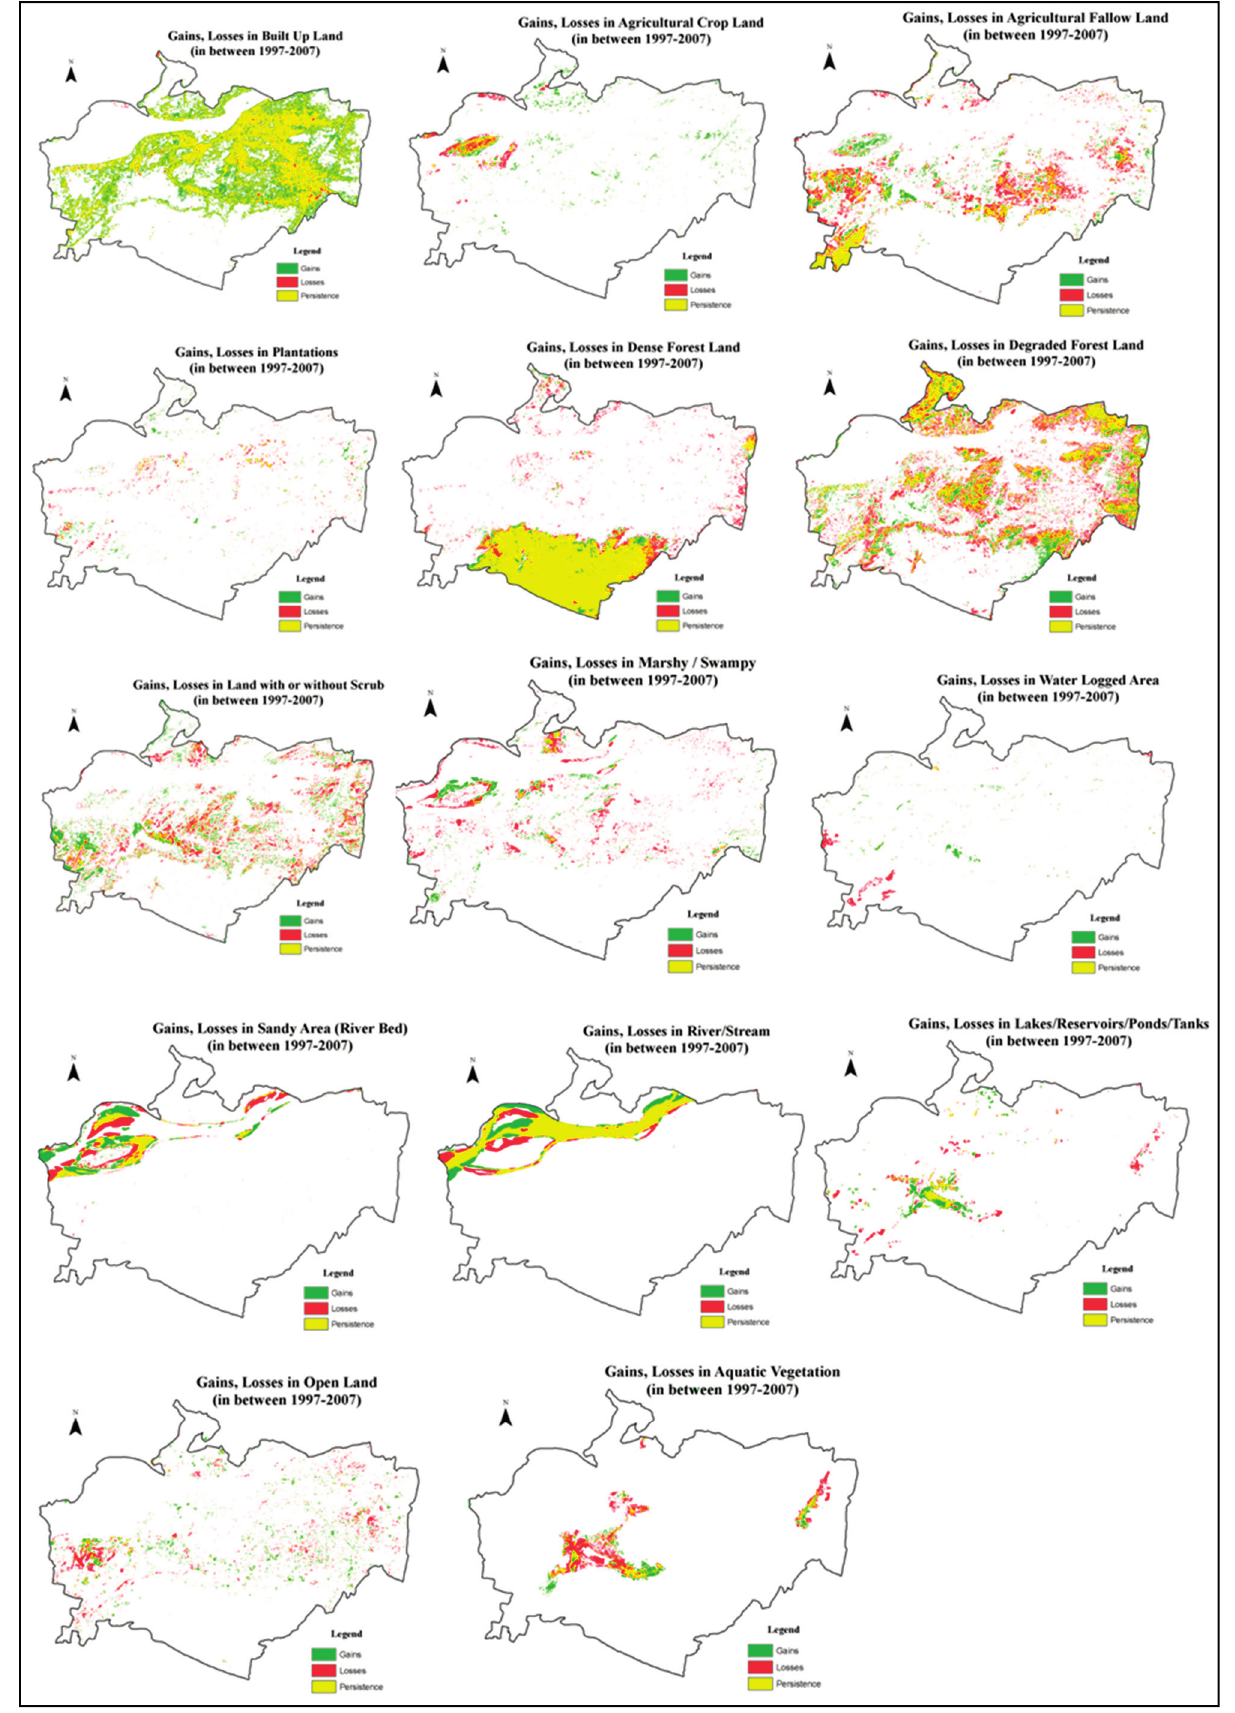
Figure 16. Gains, losses and persistence of each LULC category in time periods